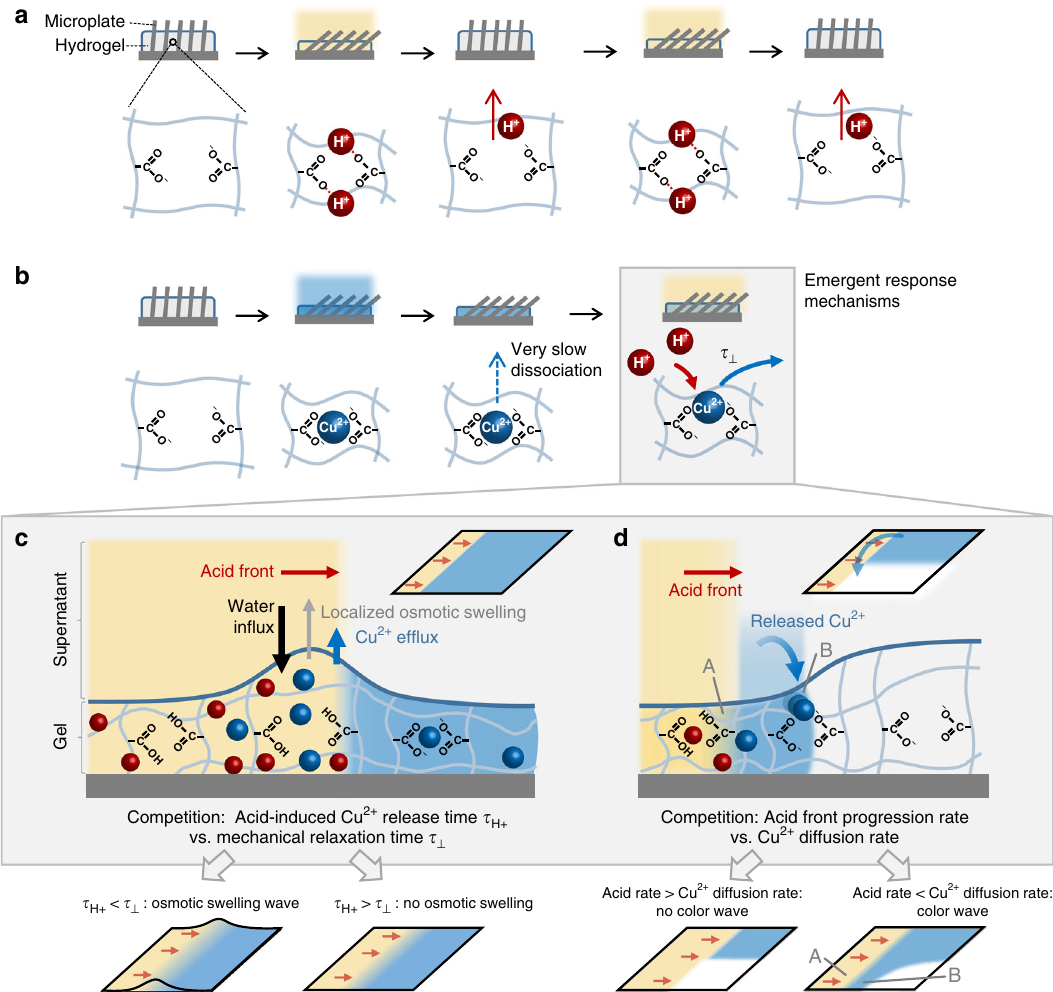
Fig. 1 Non-equilibrium coupling of stimuli across time. a Traditionally, a responsive polyacrylic acid (PAA) hydrogel contracts and swells directly in-phase with the presence or absence of an acid stimulus (yellow). Here, hydrogel contraction tilts an array of embedded microplates (gray). b In contrast to this rapid reversibility, divalent cations (Cu 2 + , blue) contract the PAA gel by forming a kinetically stable complex with two carboxylate (COO − ) groups, remaining in the gel after removal of Cu 2 + from the environment. A subsequent acid stimulus then competes for COO − groups and triggers dissociation of the Cu 2 + on a timescale determined by its delivery rate ( τ H + ). The ensuing dynamics of diffusion, complexation, and mechanical deformations in the presence of the entering and exiting stimuli can lead to scenarios depicted in c-d: c Competition between transient water in fl ux, induced by released Cu 2 + , and the mechanical relaxation time of the gel ( τ ⊥ ) creates traveling osmotic swelling waves reporting the speed of an oncoming acid front when τ H + < τ ⊥ ; d Competition between the diffusion and transient recomplexation of released Cu 2 + (top, curved blue arrow) and its re-release by oncoming acid creates rate-sensitive traveling color waves when the acid progression rate is smaller than the Cu 2 + diffusion rate (bottom right, narrow blue water. Only a slow release of Cu 2 + occurs at the edge of the layer of a sodium perchlorate electrolyte solution (NaClO 4 , 0.05 M, see Scheme in Fig. 2d, Methods and Supplementary Fig. 2). When a voltage of approx. 1 V (current 0.1 mA) is applied, the microplates near the positive electrode begin to tilt as the corresponding region of the hydrogel contracts and turns blue. The region expands outward in time with a gradient of tilt angles and color intensity, consistent with Cu 2 + ions diffusing from the electrode through the electrolyte and binding to the hydrogel (Fig. 2e and Supplementary Movie 1). The slight initial pretilting of the microplates in one orientation results in a uniform tilting direction upon Cu 2 + -complexation. As we noticed a variability in the degree of gel contraction depending on the direction of electrochemical Cu 2 + delivery, all experiments were performed such that the pretilted plates were oriented towards the Cu 2 + source, as schematically represented in Fig. 2d. Both the tilted state and blue color are maintained after Cu 2 + is removed from the external solution by rinsing the substrate with